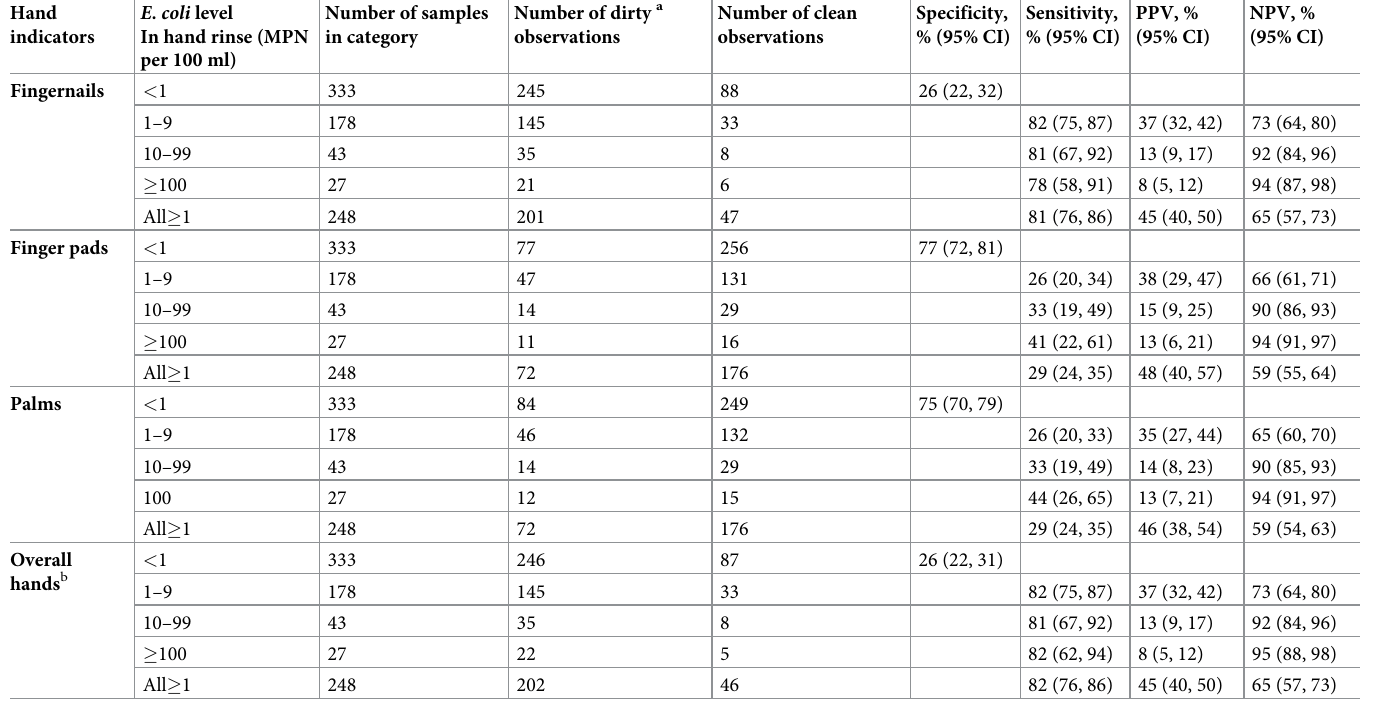
Table 4. Specificity, sensitivity, positive and negative predictive values of observed child hand cleanliness by E . coli contamination